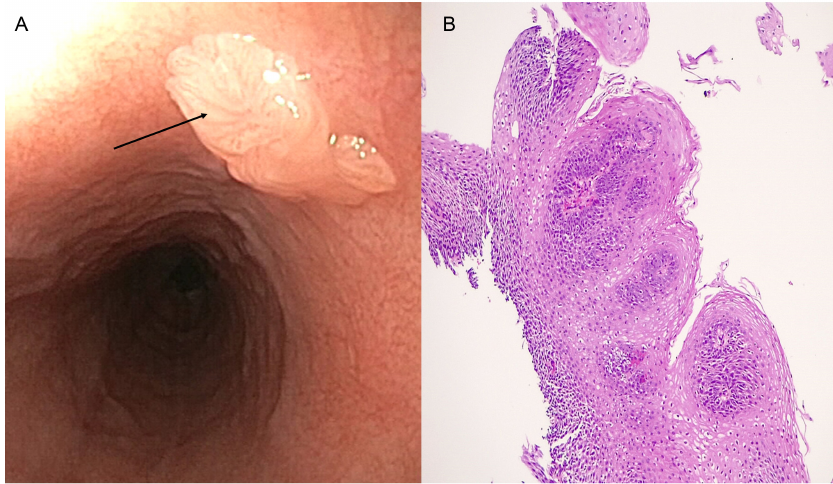
Figure 1. (A) Endoscopic image of esophageal papillomas at the level of the esophagus. An exophytic lesion of vegetative appearance, with well-defined borders. (B) Pathological image of the